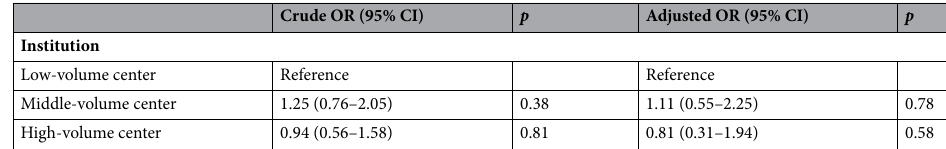
Table 4. Multivariate logistic regression analyses for in-hospital death adjusted by multiple propensity score and in-hospital variables (n = 461). A multiple propensity score was defined as the conditional probability of falling into a particular group of three groups of institutional case volume. We fitted a multinomial logistic regression model, which fell into one of the three groups as patient demographics and prehospital